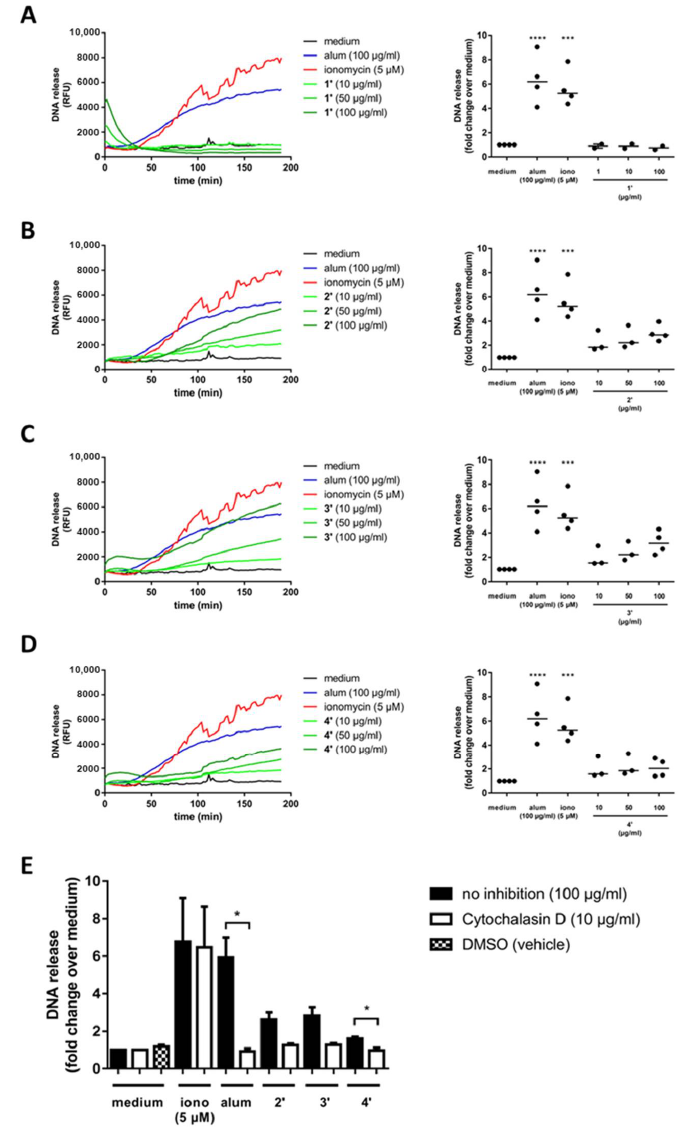
Figure 2. Silica particles trigger NET formation. The kinetics of alum, ionomycin and CysR5 1′ ( A ), RRIL-1 2′ ( B ), RRIL-2 3′ ( C ), and RRLL 4′ ( D ) silica particle-induced release of DNA were measured by fluorescence of SYTOX orange bound to extracellular DNA in plate reader assays. One representative experiment using neutrophils from different donors (AUC, area under the curve; RFU, relative fluorescence units; horizontal bar, median). Alum, ionomycin and silica particle-induced NET formation in neutrophils which had been pre-incubated for 30 min with the phagocytosis inhibitor cytochalasin D ( E ). Differences were considered statistically significant for values of p ≤ 0.05. Note: p ≤ 0.05 (*), p ≤ 0.001 (***), p ≤ 0.0001 (****).